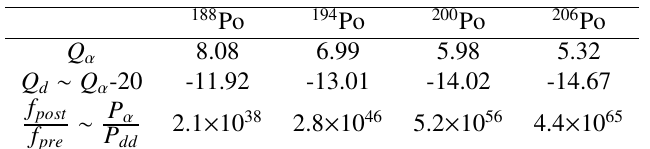
Table 1. Estimates for ratio f post / f pre with the WKB approximation. Equation (4) for α decay and for d-d individual tunneling are used for the numerical calculations. The Q d is assumed as Q d ∼ Q α -20 using experimental Q α . The assault frequencies for α and deuteron potentials are assumed to be same ( ν α = ν d ) in Equation